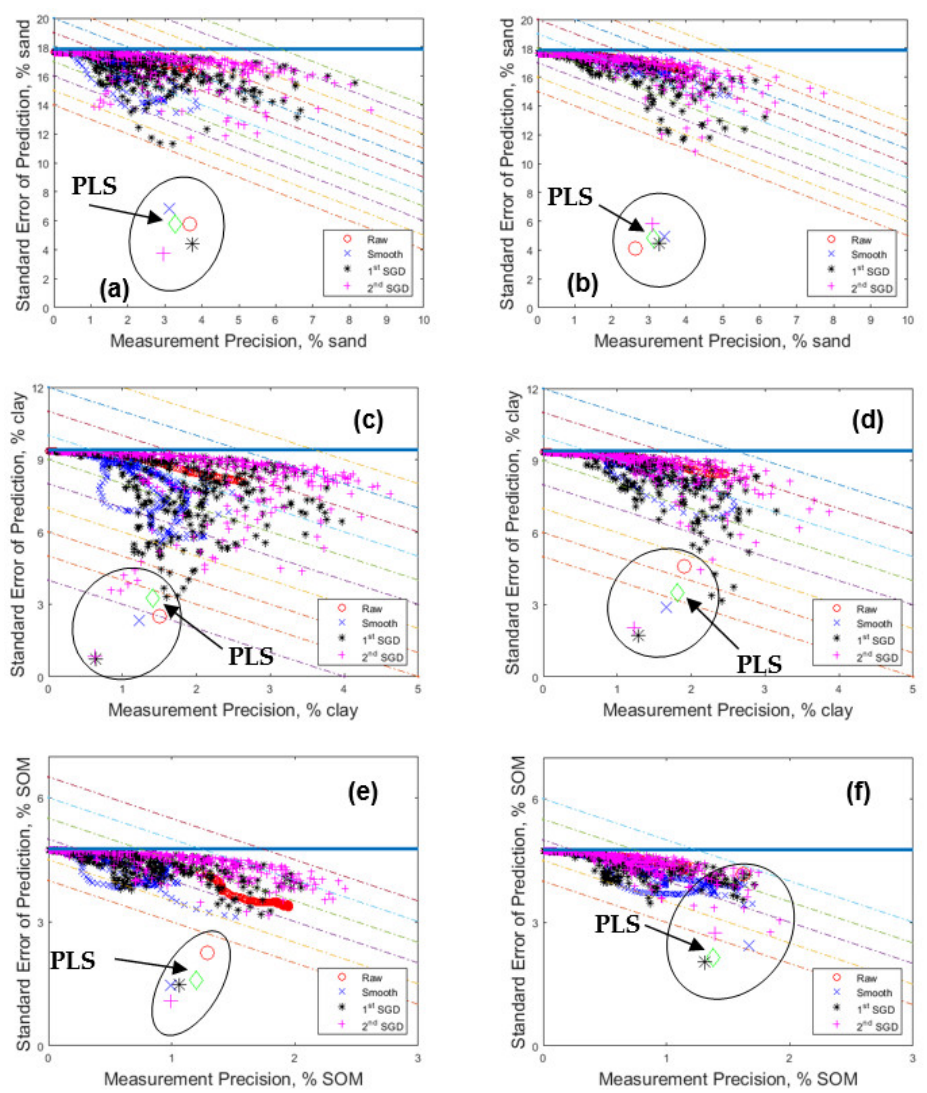
Figure 9. Precision versus accuracy comparison for the vis–NIR soil spectra, their derivatives and PLSR when predicting % sand, % clay, and % SOM using ex situ ( a , c , e ) and in situ ( b , d , f ) measure- ments. (Solid line represents the standard deviation of sand content (laboratory measurements); isolines represent the positions in the chart with the constant sum of MP and SEP; diamond symbol represents PLSR results on all spectra combined.) Table 5. The vis–NIR soil spectral bands which were capable of exhibiting the highest possible de- gree in terms of the precision and accuracy components, when predicting % sand, % clay and SOM content during ex situ measurements.